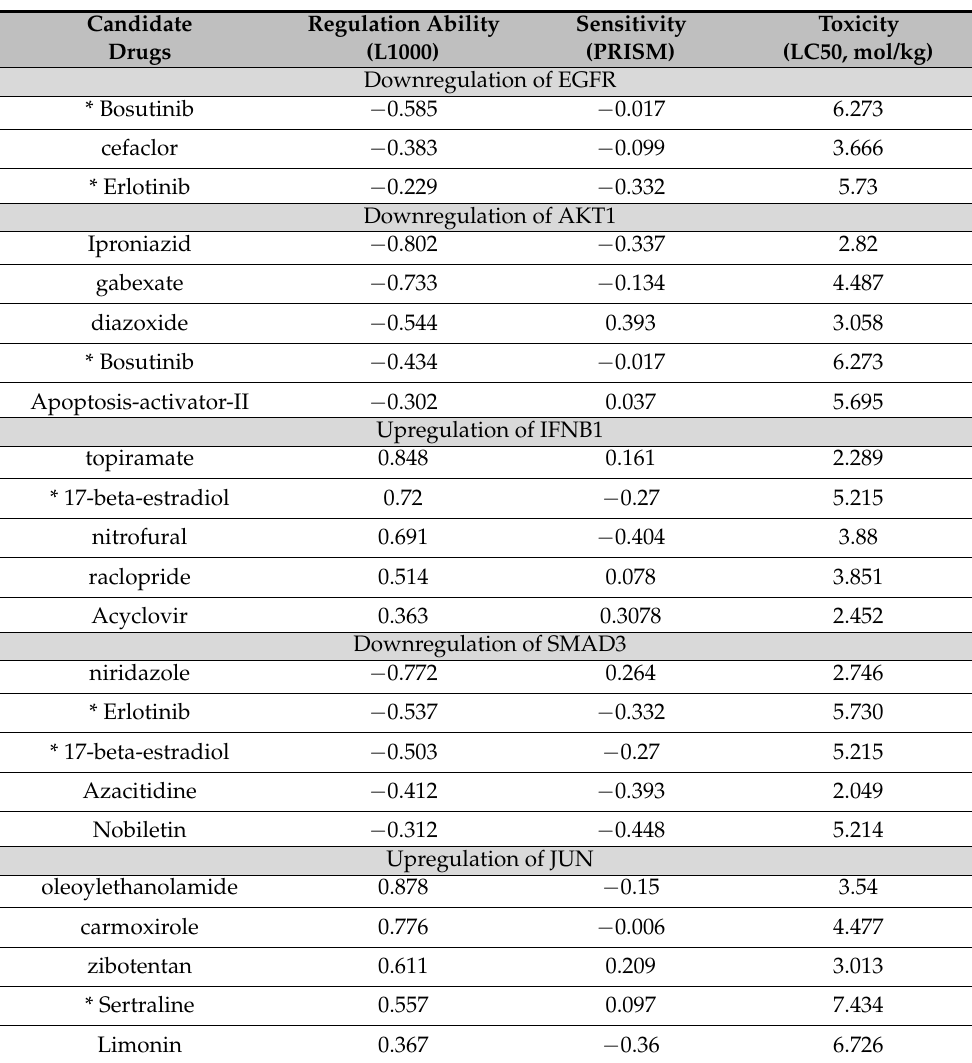
Table 5. According to drug design specifications, the candidate drugs for each significant drug tar- get are list below.